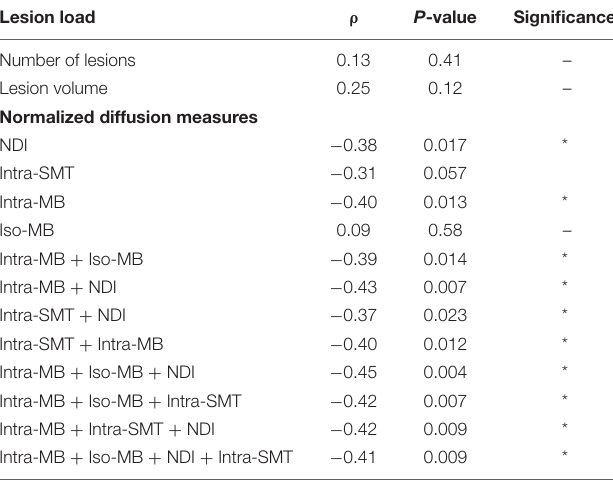
TABLE 3 | Spearman’s correlation of selected normalized diffusion measures, or their combinations and EDSS. Lesion load